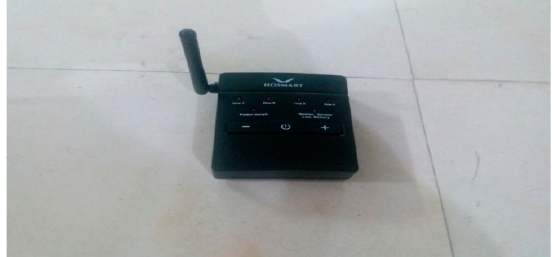
Figure 6. Base Station.